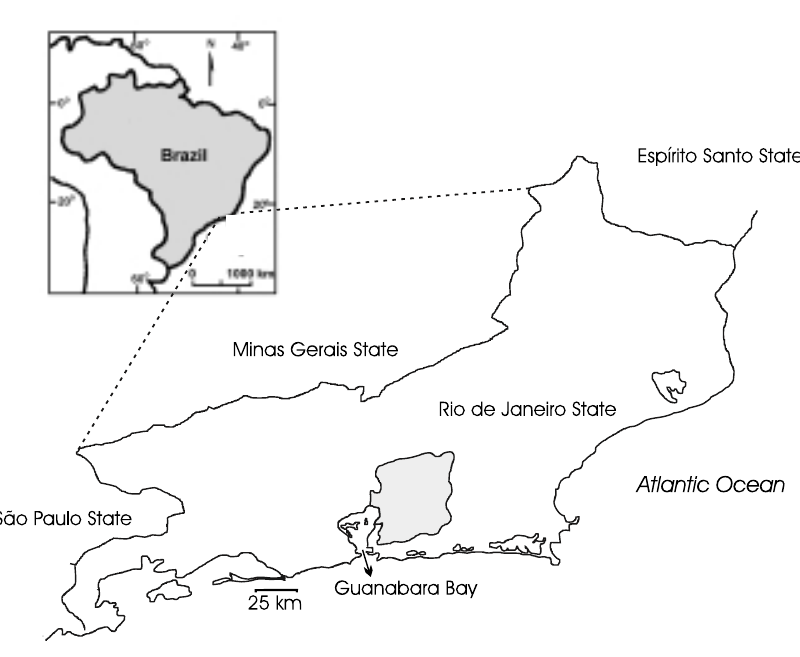
Fig. 1 – Location map of Guanabara